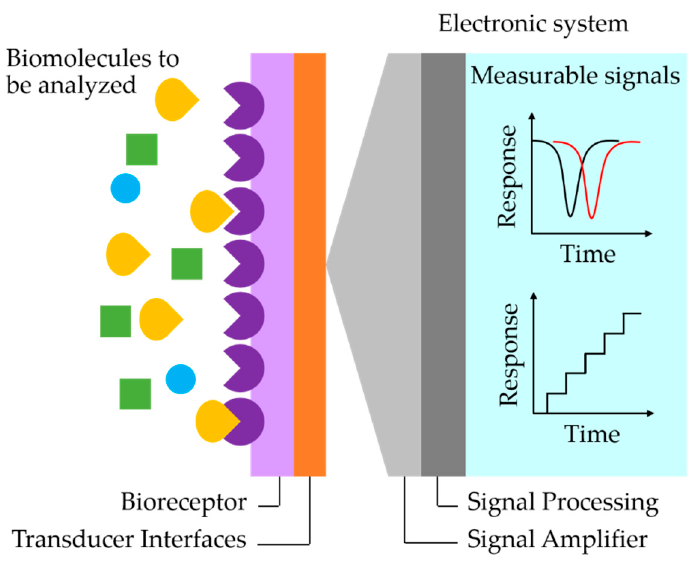
Figure 1. Schematic illustration of a typical biosensor system.